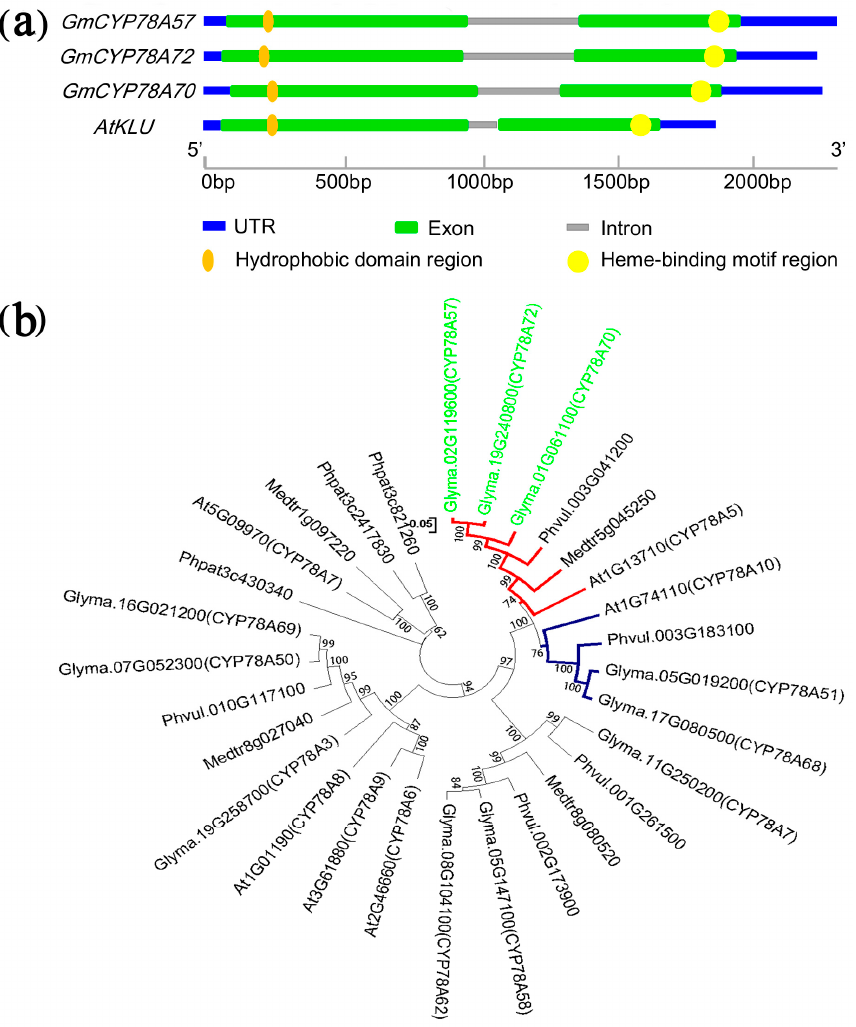
Figure 1. Gene structure and phylogenetic analysis of GmCYP78A s. ( a ) Schematic diagrams of the GmCYP78A gene structures. ( b ) Phylogenetic tree of GmCYP78As and other AtCYP78A5 homologous proteins from Glycine max , Medicago truncatula , Phaseolus vulgaris , Physcomitrella patens and Arabidopsis , constructed by MEGA7 using the neighbor-joining method. UTR: Untranslated Regions.